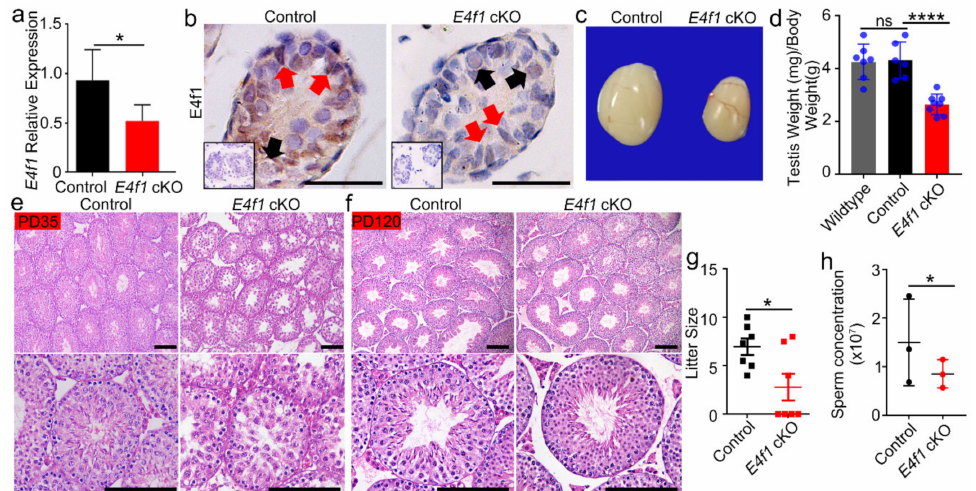
Figure 2. Loss of E4f1 in Sertoli cells resulted in reduced testis size and Subfertility ( a ) E4f1 expression level in control and E4f1 cKO testes. n = 3 ( b ) Reprehensive images of immunohistochemistry staining for E4F1 in control and E4f1 cKO testes. Black arrow indicates spermatogonia and red arrow indicates Sertoli cells. Scale bar = 50 µ m. ( c ) Representative images of the testes from control and E4f1 cKO mice at PD120. ( d ) Testis / Body weight ratio of wildtype (n = 7), control (n = 6) and E4f1 cKO (n = 8) mice at PD120. ( e , f ) Representative images of hematoxylin and eosin (H&E) stained testes of control and E4f1 cKO male mice at PD35 and PD120. Scale bar = 100 µ m. ( g ) Quantification of litter size per mice of control and E4f1 cKO male mice. n = 7. ( h ) Quantification of sperm concentration per mice of control and E4f1 cKO male mice. n = 3. *, **** denote significantly di ff erent at p < 0.05 and p <